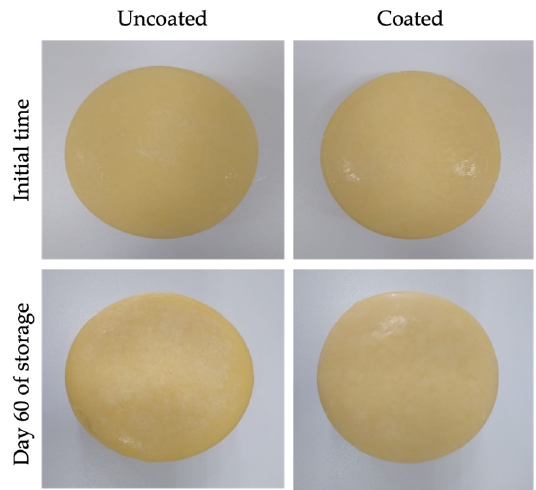
Figure 1. Images of the external appearance of uncoated and coated Paipa cheese samples at the initial time and after 60 days of refrigerated storage.